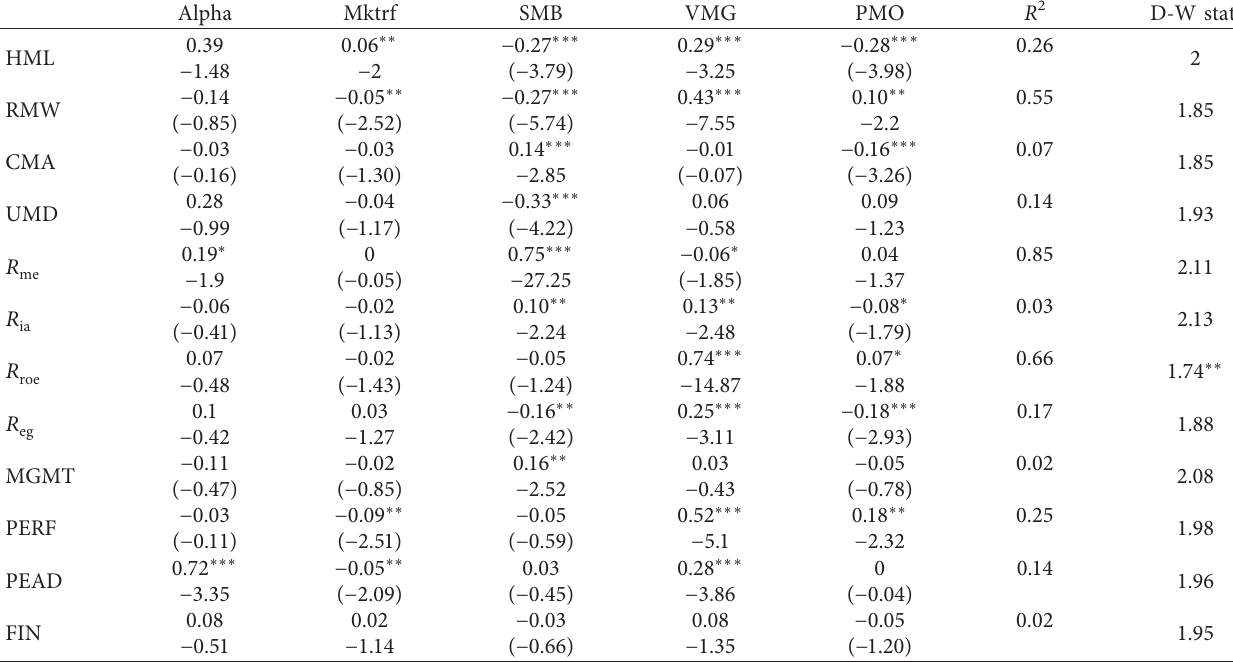
Table 6: Spanning regression. This table reports results of regressing FF6 factors, q5 factors, SY4 factors, and DHS-3 factors on LSY4 factors. MKT, SMB, VMG, and PMO are market, size, value, and turnover factors in the Liu–Stambaugh–Yuan 4-factor model [15]. HML, RMW, CMA, and UMD are value, profitability, investment, and momentum factors in the Fama–French 6-factor model [10]. R are size, investment, profitability, and expected growth factor in the Hou–Xue–Zhang q5-factor model [2]. MGMT and PERF are two mispricing factors in the Stambaugh–Yuan 4-factor model [21]. PEAD and FIN are two long-short horizon factors in the Dan- iel–Hirshleifer–Sun 3-factor model [22]. For each factor, we report its coefficient estimate and corresponding t -statistic (given in pa- rentheses). R 2 is adjusted R -squared of each regression, and D-W Stat. is corresponding Durbin–Watson statistic of each regression.